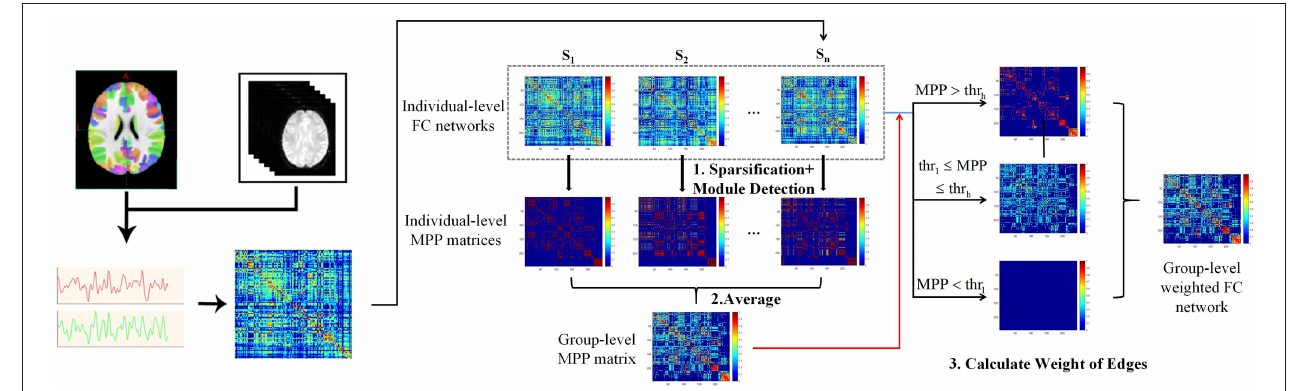
FIGURE 2 | Flowchart of brain network construction, including individual-level FC construction and the module-guided group-level network construction. First, we detected modular partition for individual-level FC networks and converted each modular partition into a matrix. That is, if two nodes are detected in the same module, the weight of the corresponding edge is 1, 0 otherwise. The modular partition matrices of each subject were averaged to obtain the individual-level “modular partition probability” (MPP) matrix, where the weight of one edge represents the probability that the corresponding two nodes assigned to the same module. Second, a group-level MPP matrix representing the module partition probability at group-level was generated by averaging all individual-level MPP matrices in the same group. Third, by combining individual-level FC networks and different weighting methods (depending on the group-level MPP and thr l / thr h ), we finally generated a group-level FC network for the